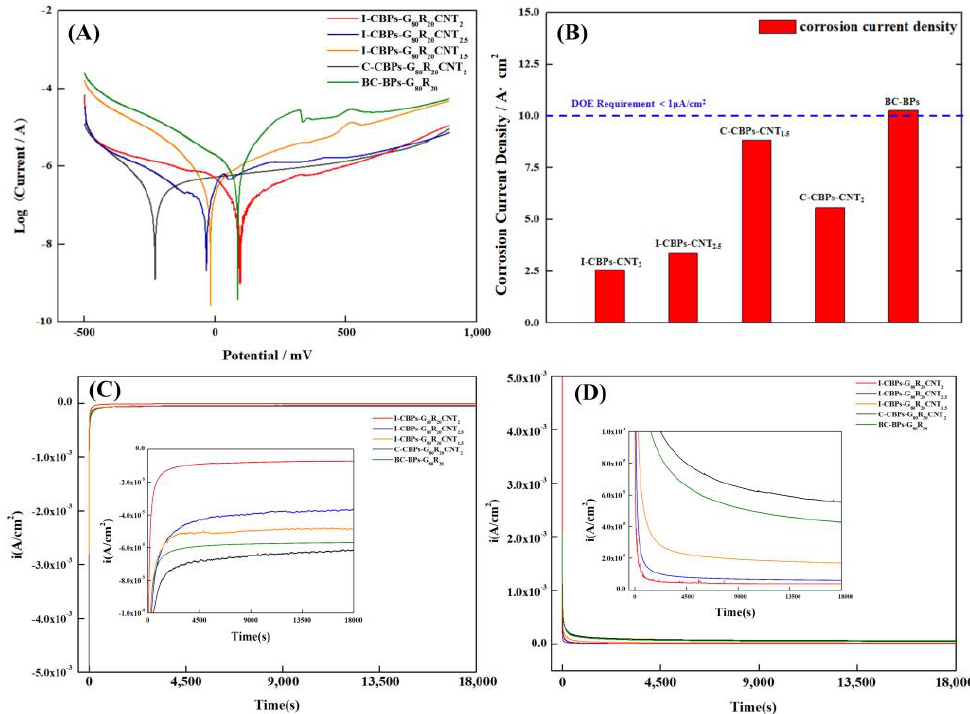
Figure 10. ( A ) Tafel curves of composite BPs; ( B ) corrosion current density of composite BPs; ( C ) constant potential polarization method to simulate PEMFC cathodic environment; ( D ) constant potential polarization method to simulate PEMFC anodic environment.